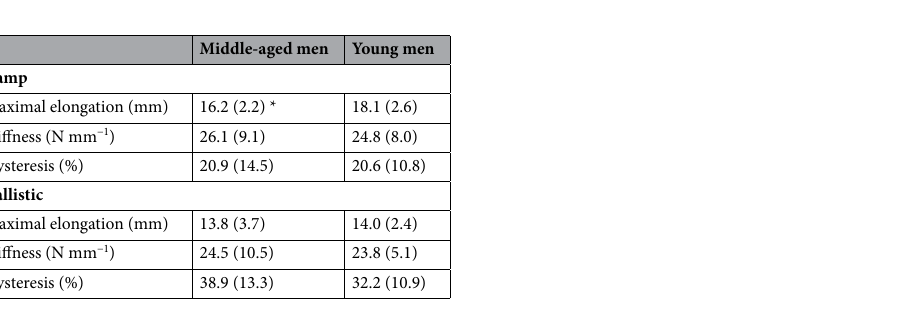
Table 2. Mechanical properties of tendon structures in middle-aged and young men Mean (sd). *Significantly different from young men (* p <